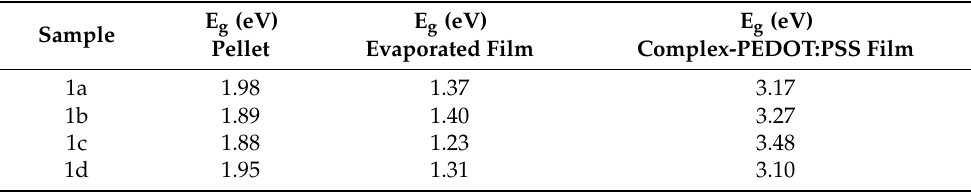
Table 1. Forbidden gap energy of heptacoordinated organotin (IV)